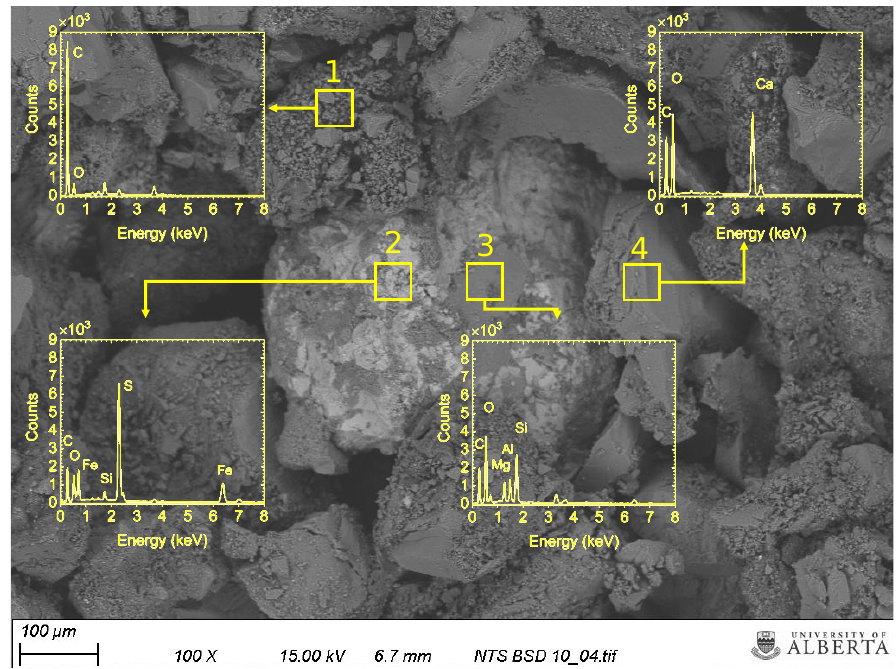
Figure 4. The EDS spectrum for four different regions in the first scale sample. Region 1 has a strong carbon peak with a very small oxygen peak. This indicates the presence of organic matter in the scale. Region 2 has strong sulfur and iron peaks, suggesting the presence of iron sulfide in this region. Region 3 has aluminum, magnesium and silicon peaks, suggesting the presence of Mg-based silicate scales. Region 4 has calcium, oxygen and carbon peaks, indicating the main components of calcite/aragonite minerals.